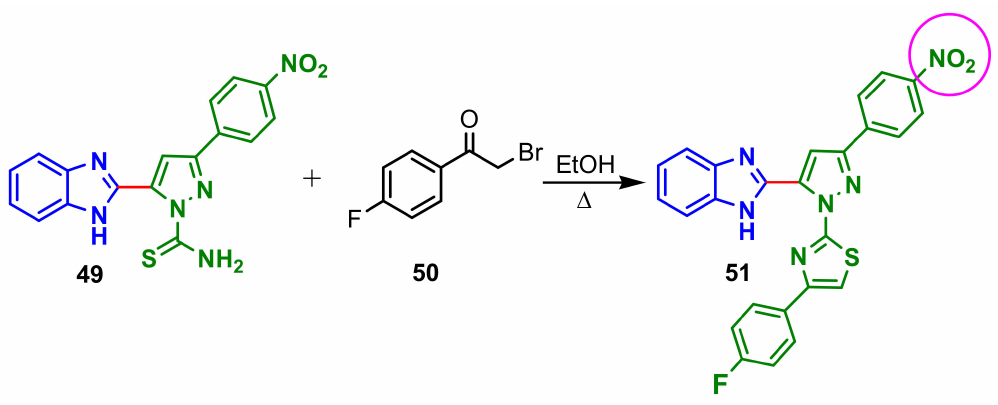
Scheme 13. Synthesis of dibenzimidazole–pyrazole 51 .